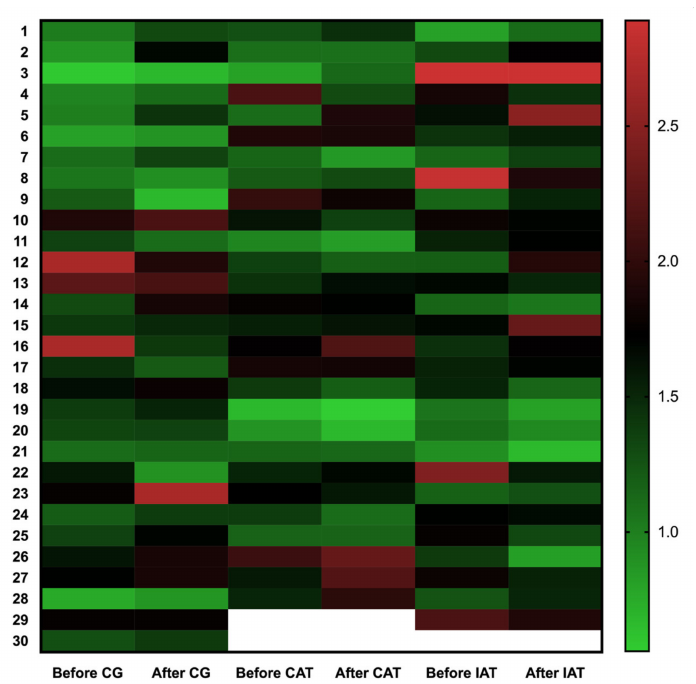
Figure 2. Heatmap of telomere length (T/S ratio) variation before and after 16 weeks of continuous and intermittent aerobic physical training or observation period.